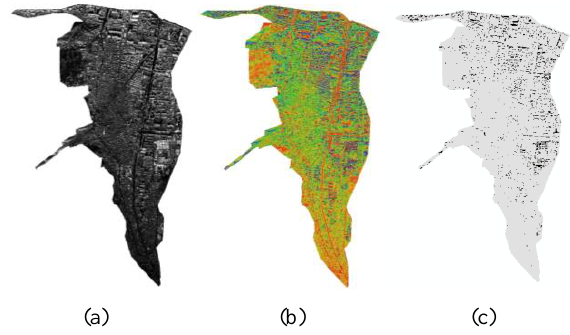
Figure 7. SAR image (a) and its synthetic colour image by features in frequency domain (b), extracted highlighted area (c). Such transformation preserves the details of the radar image and improves the effectiveness of the SAR image interpretation. The highlight area and other area are selected as 2 class regions.